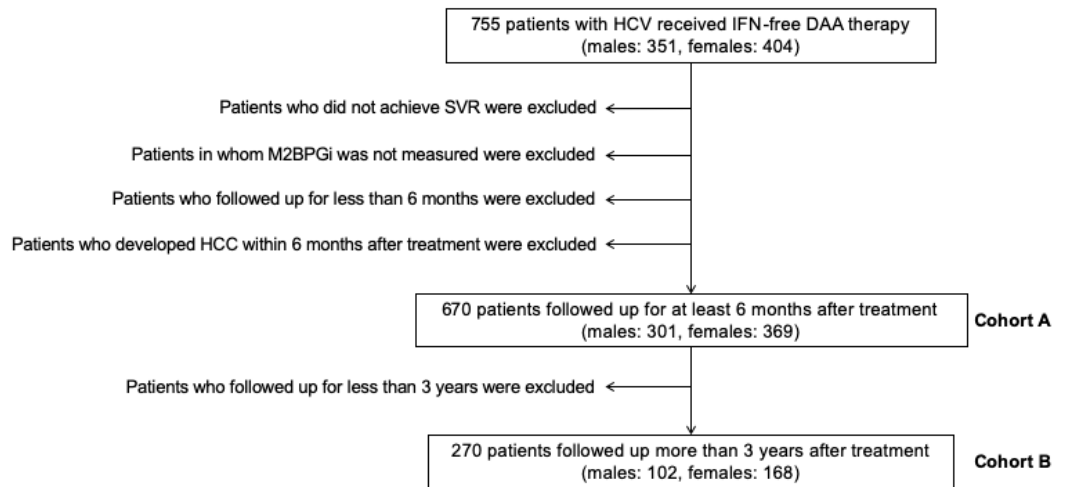
Figure 1. Selection of eligible patients. HCV: hepatitis C virus; IFN: interferon; DAA: direct-acting antiviral; SVR: sustained viral response; M2BPGi: Wisteria floribunda agglutinin positive Mac-2 binding protein; HCC: hepatocellular carcinoma.